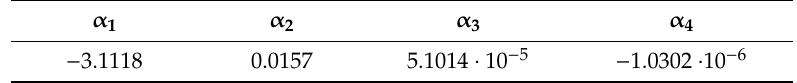
Table 3. Coe ffi cients a i , i = 1 ... 4 of Equation (28) used for the calculation of seawater isobaric heat capacity (Reproduced with permission from [20]. Elsevier,